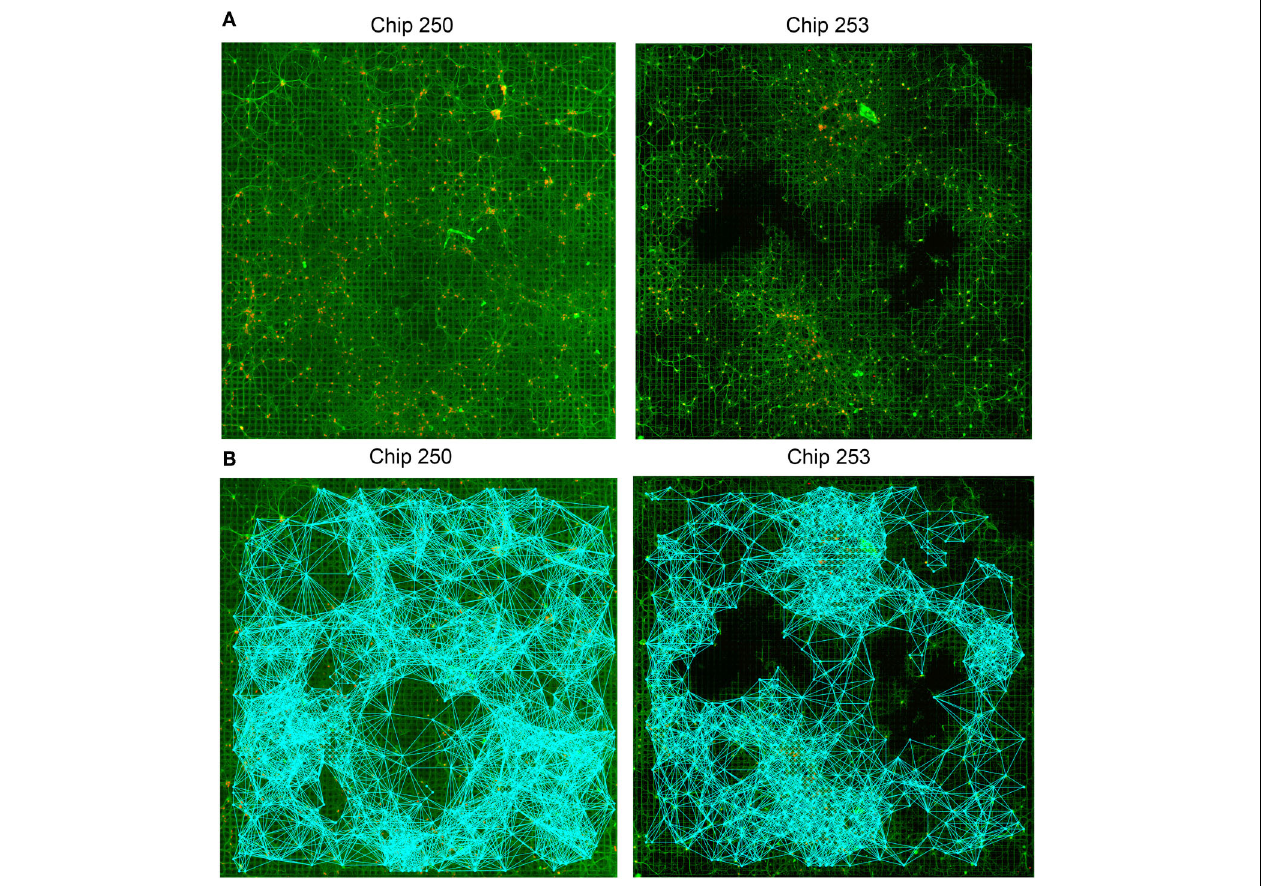
FIGURE 5 | Structural connectivity graphs. (A) Original fluorescence images of two neuronal networks (Chip-250 and Chip-253). (B) Resulting structural connectivitygraphsestimatedwiththeGHKframework.Thenetworkspresenthighdegreeofconnectivity(5570SClinksforChip-253and7808linksforChip-250).